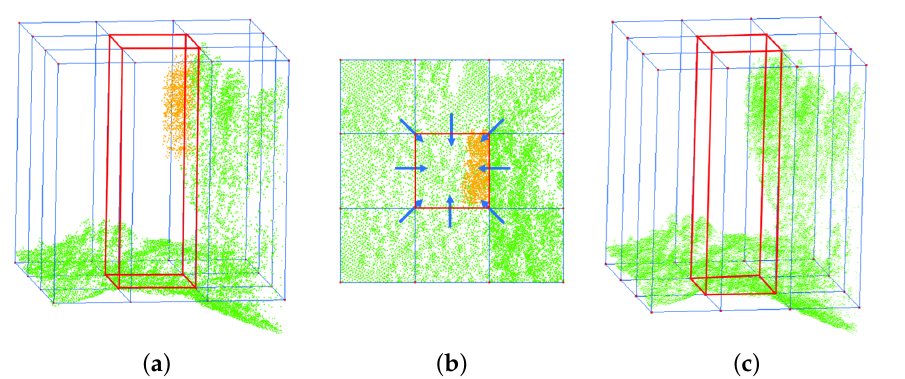
Figure 5. Removal of false positive power line points using region growing. ( a ) The 3 × 3 neighbor- hood cells (blue cells) of candidate power line points (orange points in the central cell). ( b ) The top view of ( a ) to illustrate the region growing that proceeds inwards along with the blue arrows. ( c ) The result after region growing, where the candidate power line points are corrected as points of